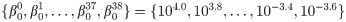
Results for the Heinrich Model.(A, E, I) The temporal profiles of the response relaxation for different values of β0, β1, and β2. In (A), we set β1 and β2 equal to their base values from Table B in S1 Appendix. We then integrated the Heinrich model for the β0 values taken from the set {β00,β01,…,β037,β038}={104.0,103.8,…,10−3.4,10−3.6}. (B, F, J) The consecutive similarity in the temporal profiles for β0, β1, and β2. We consider the system to display dynamics robustness against a parameter if this measure is less than 0.3. The gray portion of the lines in (B, F, J) indicate that the system is in a deactivated state (i.e., g2 < 0.5) for those values of βi. (C, G, K) The half-life of the response as a function of β0, β1, and β2. The magenta triangle indicates when the βi value becomes the minimum β value. The black dot represents the base βi value from Table B in S1 Appendix. The grayed out region indicates that the system is in a deactivated state for those values of βi. The region between the dashed vertical lines indicate that the magnitude logarithmic gain of the duration against βi is less than 0.3. The dashed green line is g2 as a function of βi. (D, H, L) The logarithmic gain of the duration against β0, β1, and β2.